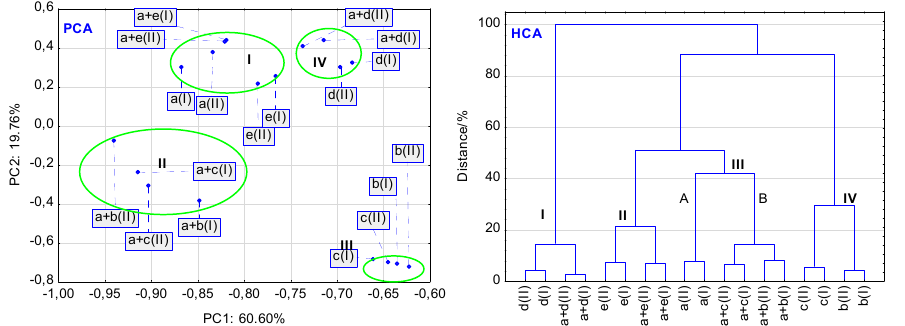
Figure 11. Findings of multivariate calculations using FT-IR data: PCA score scatter plot, and HCA tree diagram. Linagliptin = a(I) and a(II), lactose = b(I) and b(II), mannitol = c(I) and c(II), magnesium stearate = d(I) and d(II), and polyvinylpyrrolidone = e(I) and e(II). Physical mixtures of linagliptin with lactose = a + b(I) and a + b(II), mannitol = a + c(I) and a + c(II), magnesium stearate = a + d(I) and a + d(II), and polyvinylpyrrolidone = a + e(I) and a + e(II). (I and II) denote the non-stressed and stressed samples,